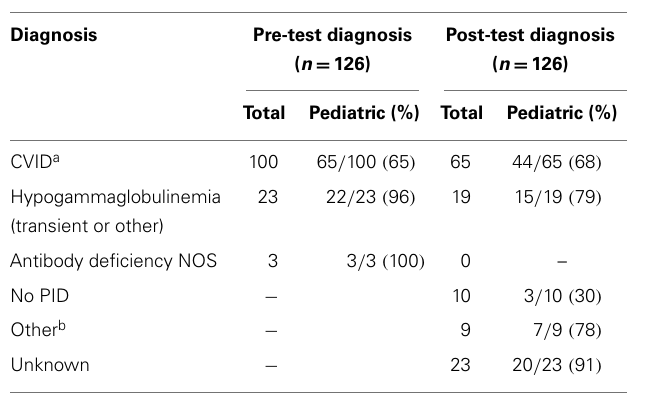
history.The types of infections are shown among the patients evaluated with bacteriophage immunization. See text for greater